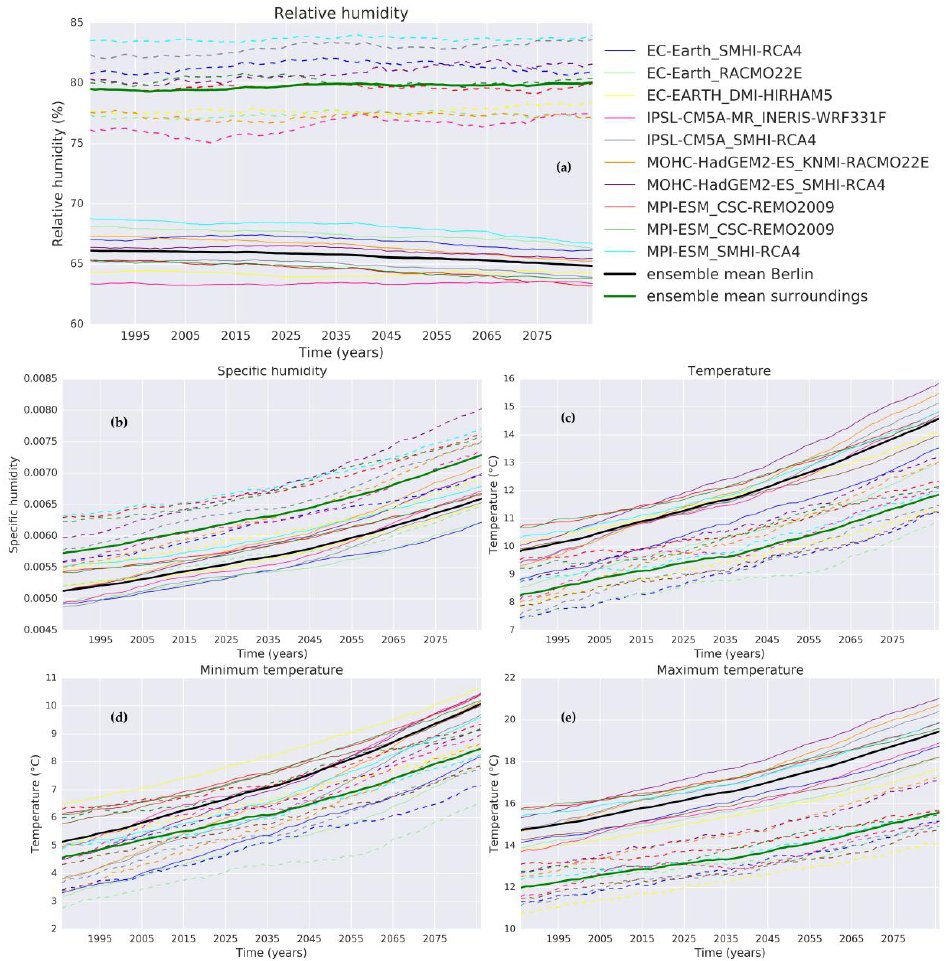
Figure 2. Running 30-year mean for 1970 – 2099 for individual European Coordinated Regional Climate Downscaling Experiment (EURO-CORDEX) models and the multi-model mean for ( a ) relative humidity, ( b ) specific humidity, ( c ) temperature, ( d ) minimum temperature, and ( e ) maximum temperature for Representative Concentration Pathway (RCP) 8.5, comparing Berlin (solid lines) and its surroundings (dashed lines).